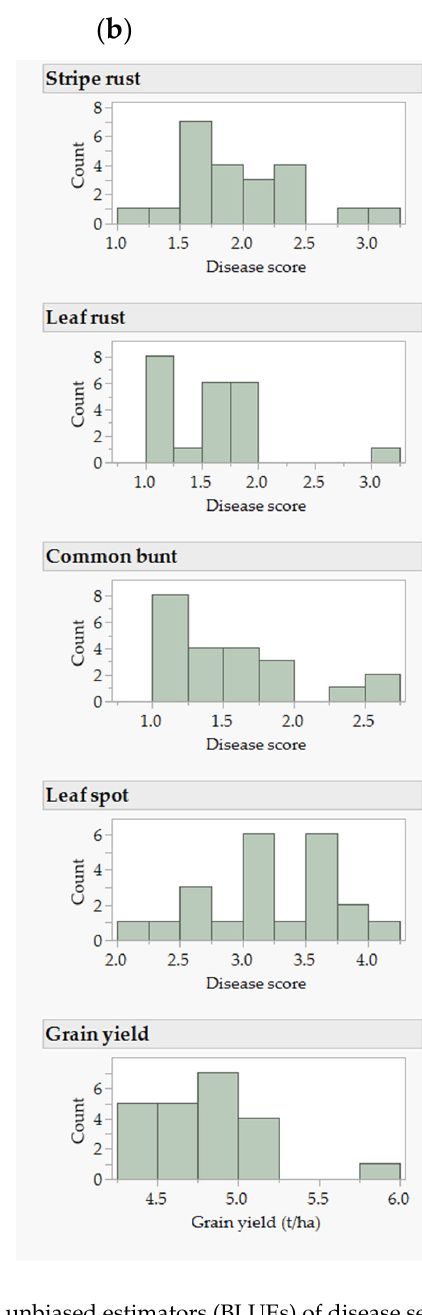
Figure 1. Frequency distribution of the best linear unbiased estimators (BLUEs) of disease severity and grain yield computed from all environments for ( a ) all 196 genotypes, and ( b ) the 22 selected genotypes. For all four diseases, we considered genotypes with a mean disease severity score of 1–2, 2.1–3.0, 3.1–5.0, 5.1–7.0, and 7.1–9.0 as resistant, moderately resistant, intermediate, moderately susceptible, and susceptible, respectively.